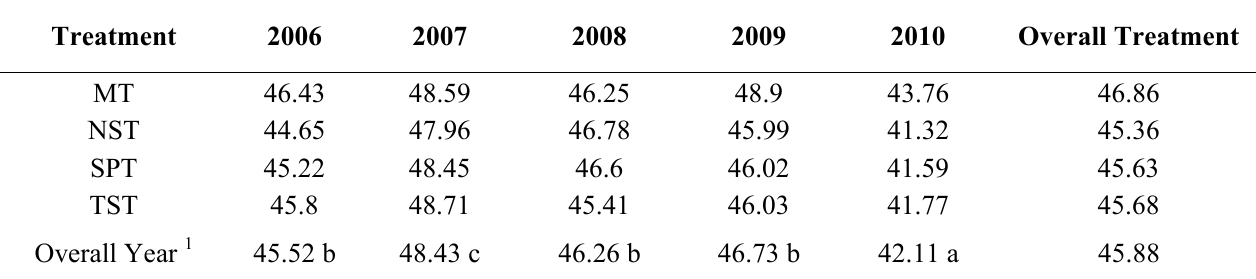
Table 3. Estimated cumulated GHG emissions for the season (kg CO lambs removed from the treatment group at slaughter weight of 38 kg.